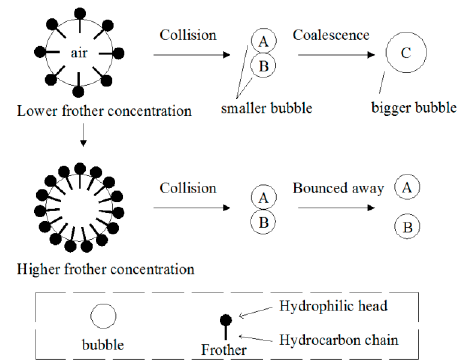
Figure 8. Effect of MIBC molecular concentration adsorbed on the surface of bubbles during collision, coalescence, and bouncing away of bubbles.